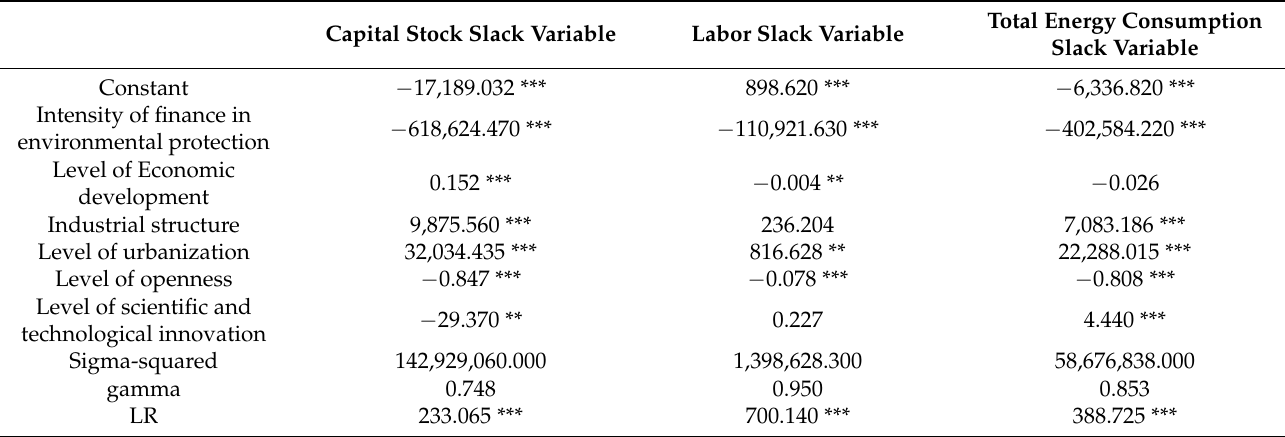
Table 3. Regression results of stochastic frontier